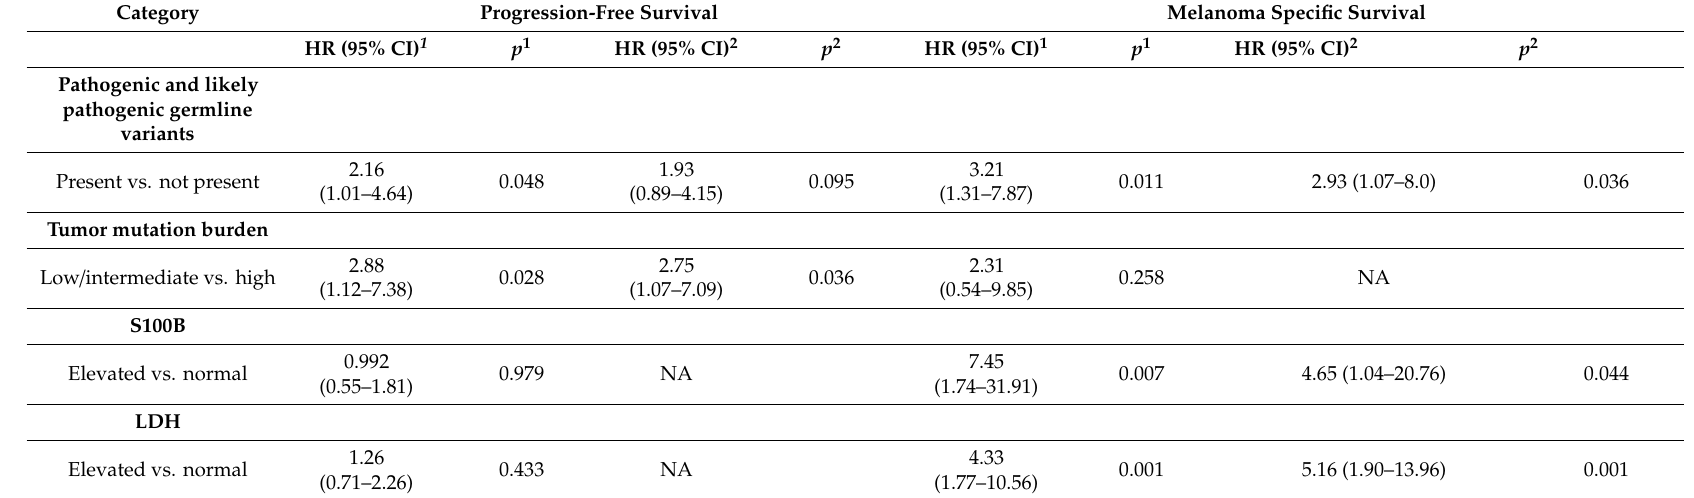
Table 4. Progression-free survival and melanoma specific survival dependent on potential